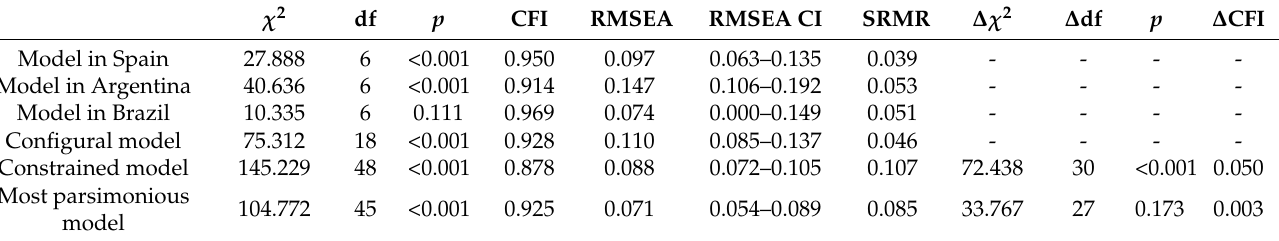
Table 3. Fit indices of the multisample path